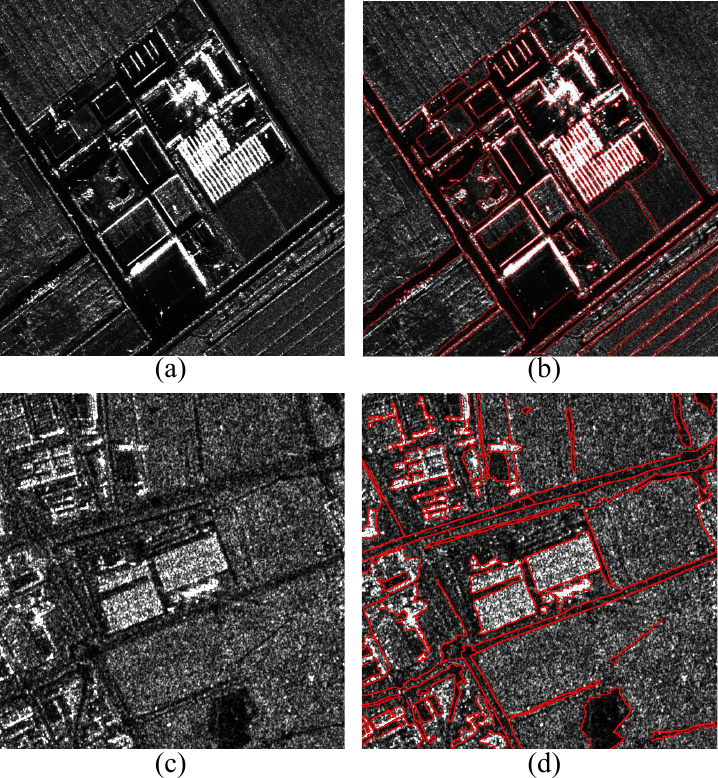
Figure 6. Real SAR images. ( a ) X-band. ( c ) C-band. ( b ) Ground truth of ( a ). ( d ) Ground truth of ( c